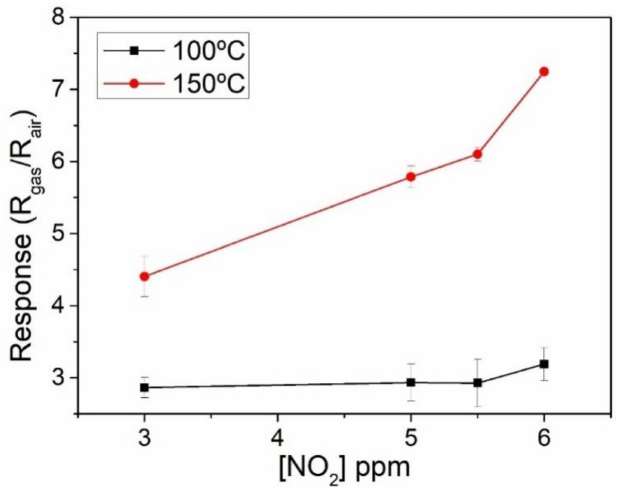
Figure 7. Sensor response towards NO 2 at two different operating